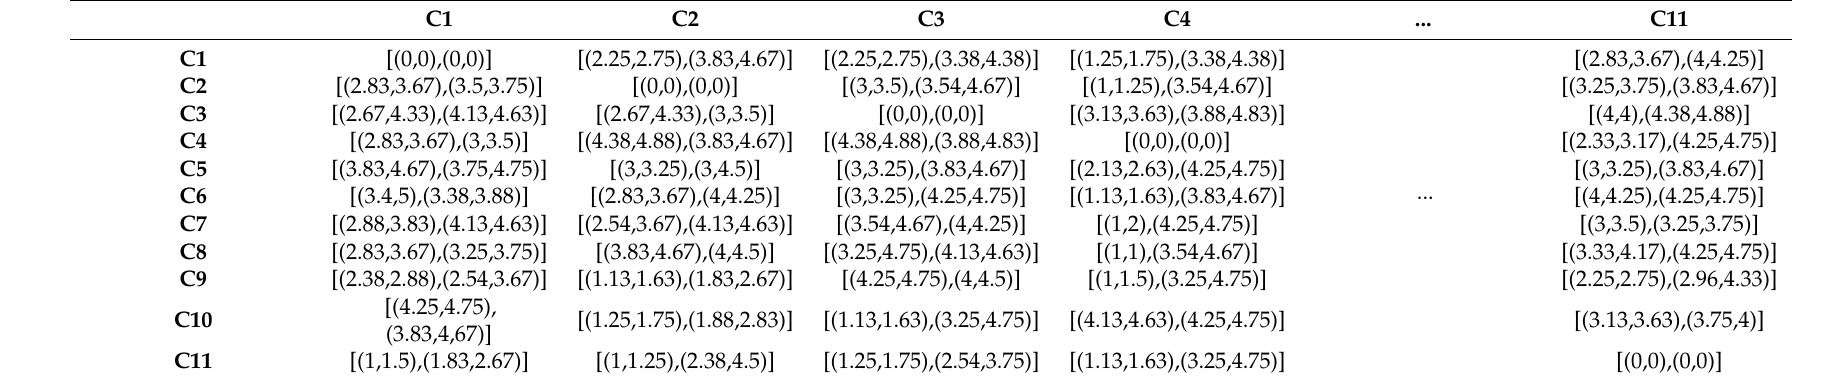
Table 5. Interval rough average matrix of the conditioning factors.